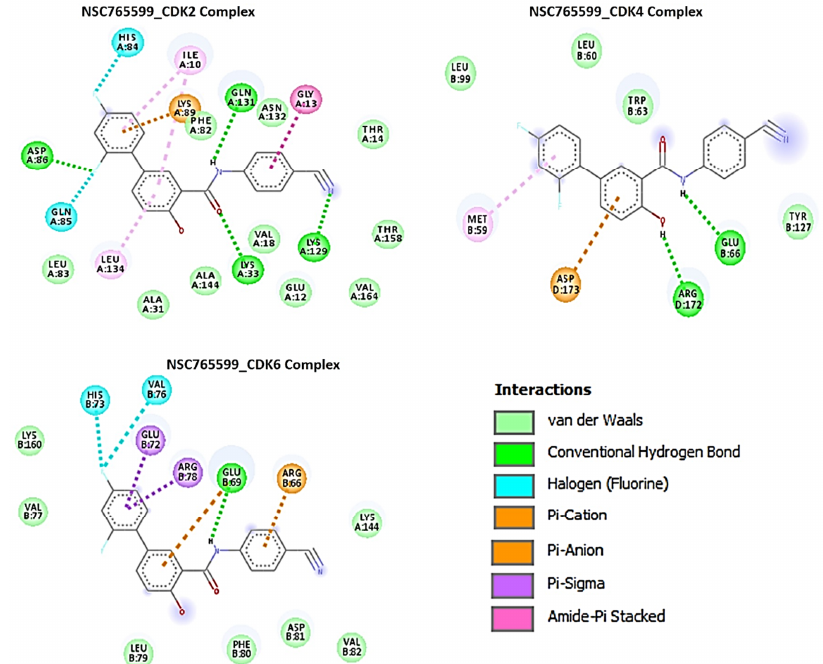
Figure 6. Docking profiles of NSC765599 with CDK2, CDK4, and CDK6. Two dimensional (2D) representations of ligand– receptor interactions occurring between NSC765599 and the target receptors (CDK2/4/6). The deep-green color indicates the strongest ligand–receptor interaction (due to conventional hydrogen bonds) of the best docking pose. Table 6. Comparative docking profile of NSC765690, NSC765599 and standard STAT3/CDK2/4/6 inhibitors.